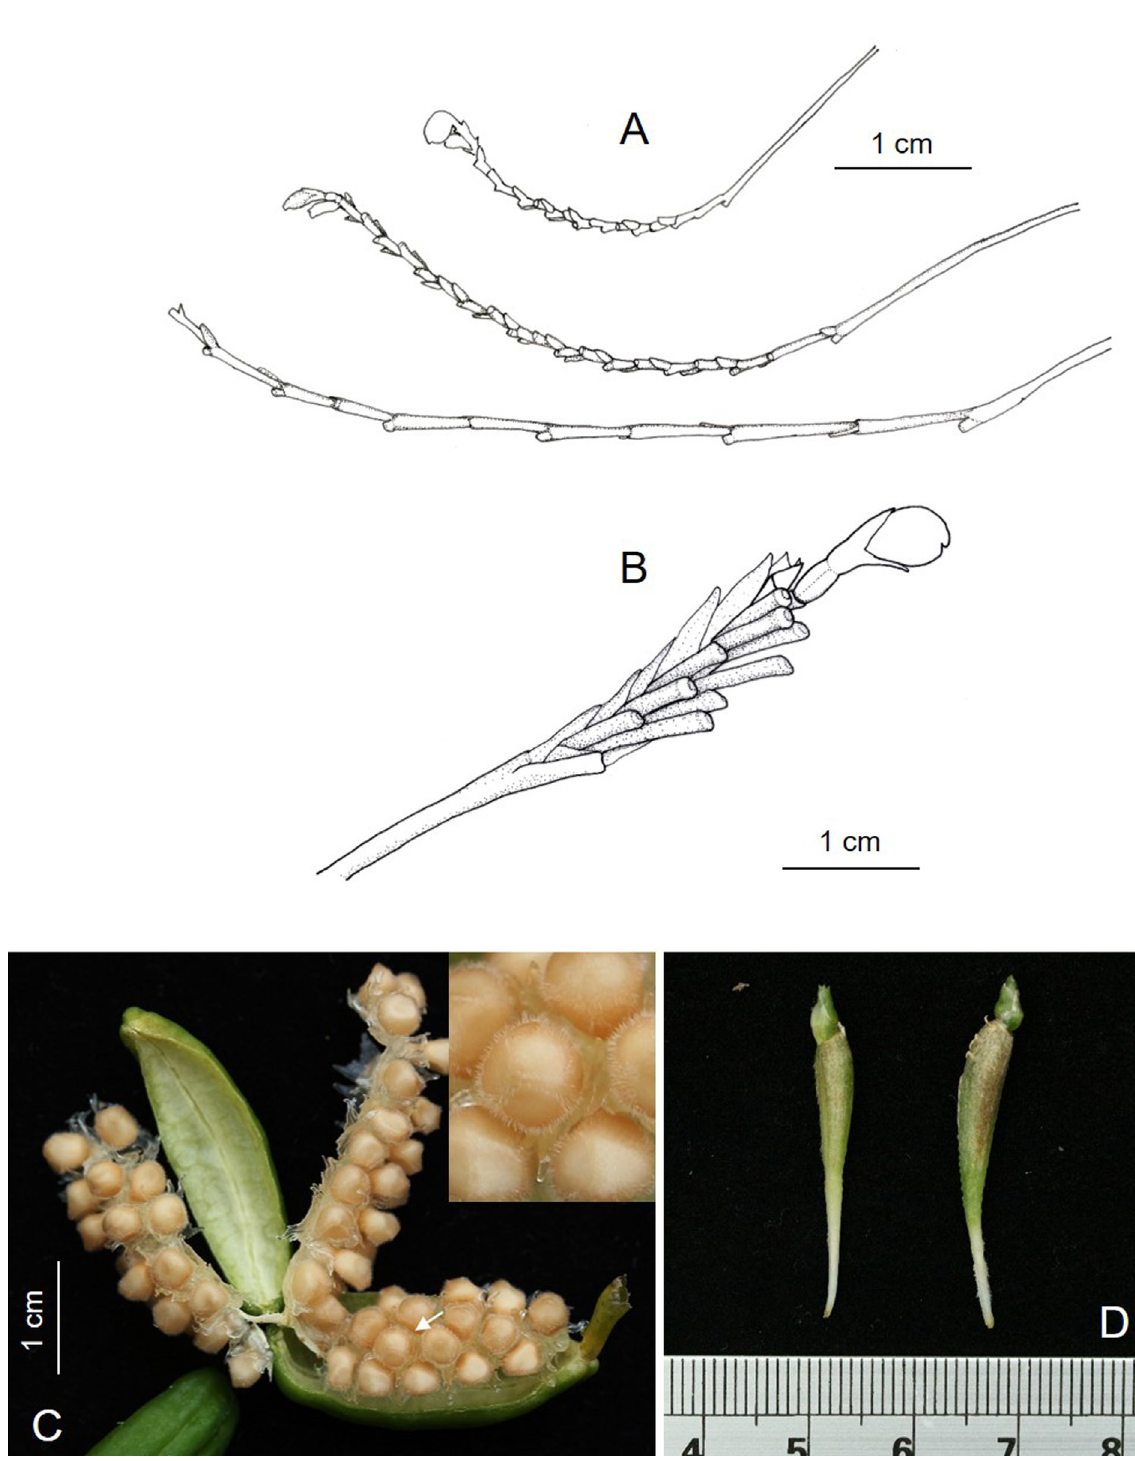
Fig. 1. Cincinnus morphology in G. subsect. Nudae K.Larsen. A . Lax cincinni (M.F. Newman 2561 leg.). B . Crowded cincinnus (S. Sangvirotjanapat 642 leg.). C . Seeds (M.F. Newman 2561 leg.); the area in the inset is indicated by a white arrow. D . Bulbils (M.F. Newman 2561 leg.). Drawings and photographs: S.